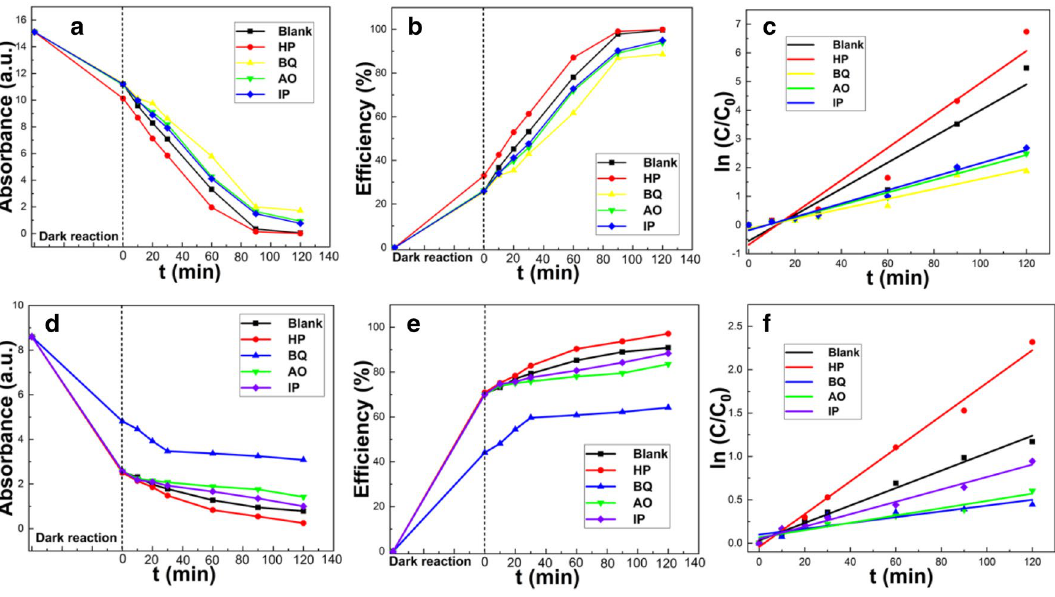
Figure 7. Effects of scavenger and superoxide on MB ( a – c ) and CR ( d – f )